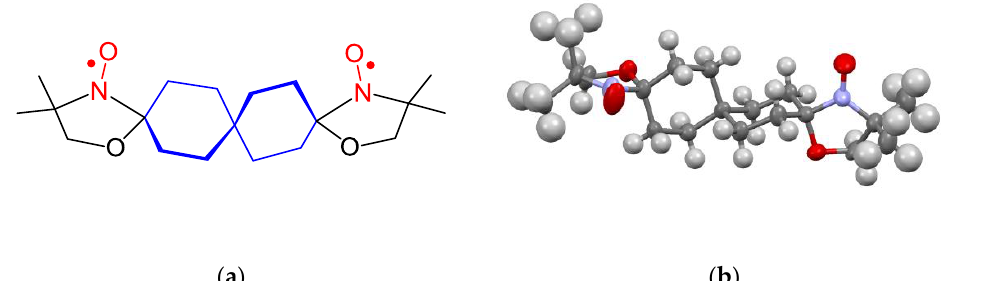
Figure 15. Crystal structure of biradical 365 . ( a ) 2D, ( b ) 3D.